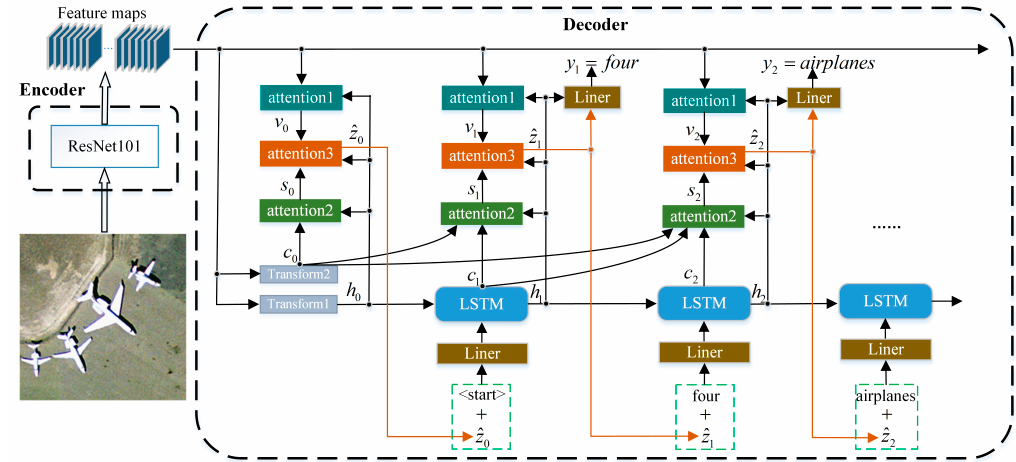
Figure 2. The architecture of our multi-level attention model. Firstly, and image is resized into 224 pixels × 224 pixels, and then ResNet101 is used as the decoder to extract the convolution layer of the image. In the decoder, h and c are firstly initialized using extracted feature maps and "Transform" blocks. Arrows indicate the flow of data. The "attention1" gets the expression of attention to different regions of the image, which is expressed by the vector v t . The “attention2” gets the expression of attention to different words in a sentence that has been generated, which is expressed by the vector s t . The “attention3” refers to the attention to v t and s t , which is expressed by the vector ˆ z t . The ˆ z t obtained by attention is combined with the predicted y t − 1 of the previous moment and input into the LSTM at time t . These operations predict the word y t , and will continue until y i = < end > .